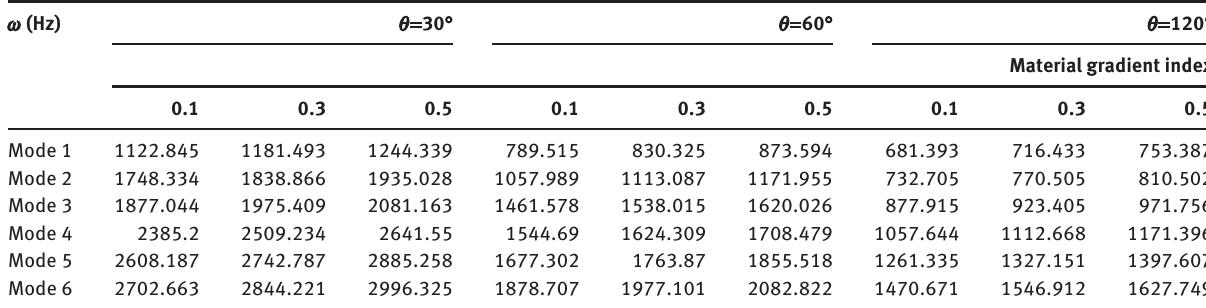
Table 4 Natural frequencies of a fully clamped orthotropic FG annular sector plate for different power-law exponents and sector